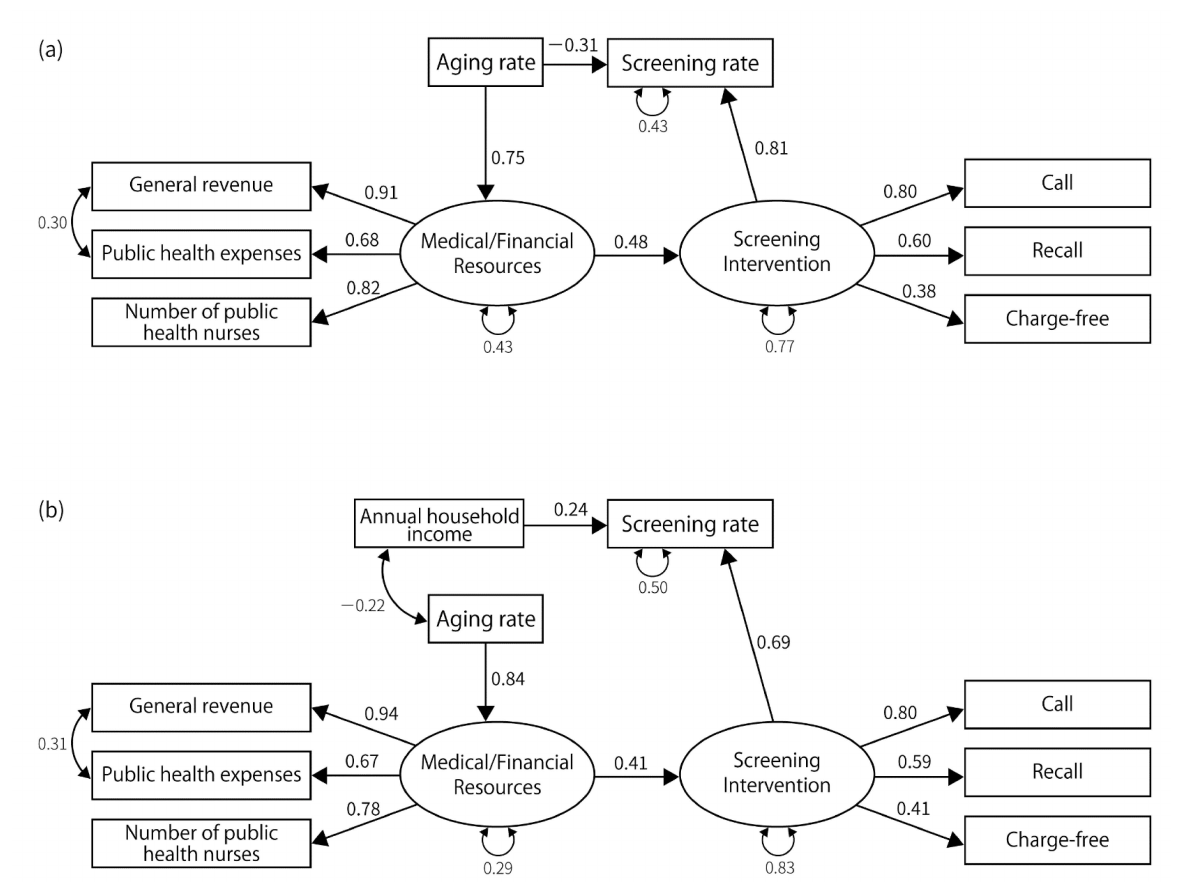
Figure 3. The final model for lung cancer. ( a ) The final model for lung cancer screening in males. GFI = 0.943, AGFI = 0.878, PGFI = 0.445, SRMR = 0.070, CFI = 1.00, RMSEA = 0.000, p -value by χ 2 test = 0.683, χ 2 = 13.77, degrees of freedom = 17. ( b ) The final model for lung cancer screening in females. GFI = 0.887, AGFI = 0.789, PGFI = 0.473, SRMR = 0.093, CFI = 0.94, RMSEA = 0.096, p -value by χ 2 test = 0.077, χ 2 = 34.438, degrees of freedom = 24.